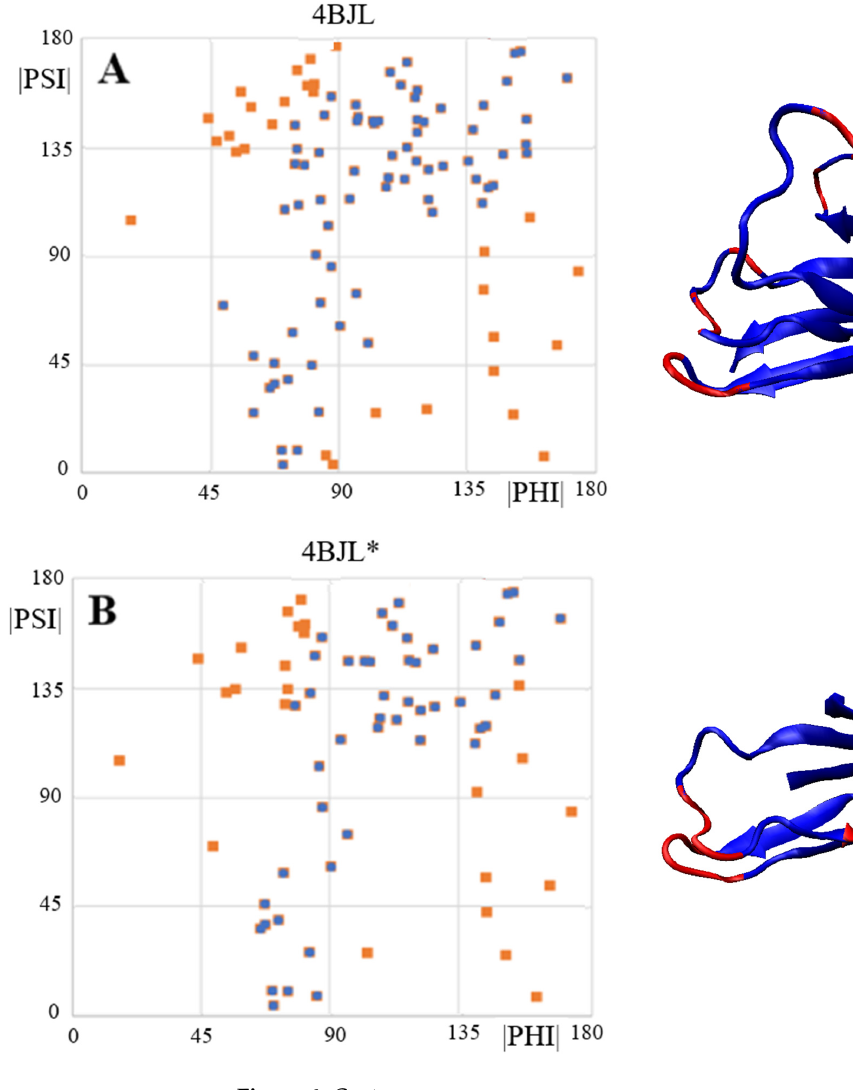
Figure 6. The 3D display of the fibril reveals the location of residues with a conformation deviating from the model at the starting or ending positions of segments with a linear β‐ structure form. ( A ) – the complete V domain of IgG. ( B )—part of domain V of the IgG light chain as present in amyloid form of this amyloid—highlighted in the 3D presentation as in point A. ( C )—amyloid form of do ‐ main V of IgG light chain ‐ amino acids highlighted in a 3D presentation as in Figure 5. * ‐ denotes the section of V domain present in the amyloid form. A comparative analysis of the Phi and Psi angle profiles in the wild type and amyloid forms reveals a significant degree of order, especially in terms of the presence of angles with the relation |Psi| = |Phi| in the amyloid form (Figure 7). Such ordering is not present at all in the native form, except perhaps for the short fragment 15–22 and 85–90. In the amyloid structure, segments with this ordering are present to a much greater extent (8– 15, 23–29, 81–95), as are short segments such as, for example, the C ‐ terminal and N ‐ termi ‐ nal segments of 1–37 and 66–105.